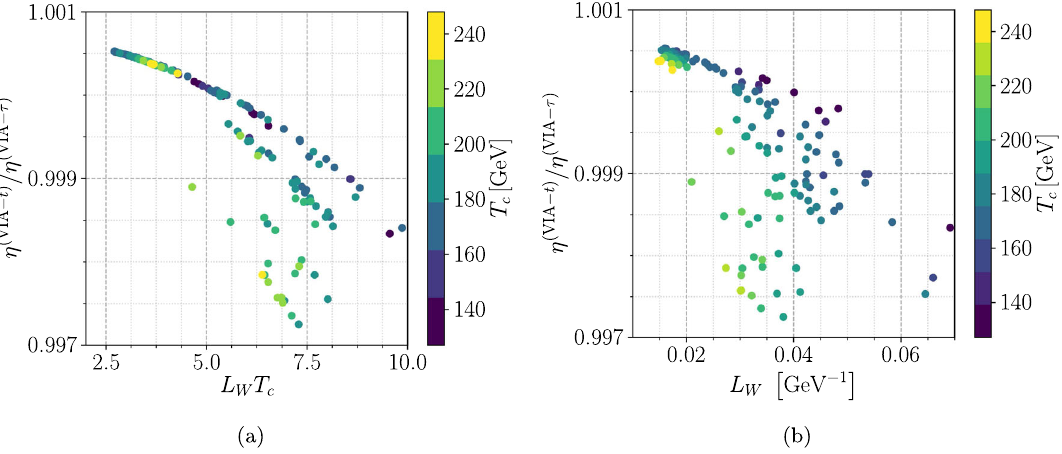
Fig. 9 Ratio between the BAU computed in the VIA − t approach and the VIA − τ approach as a function of L W T c (left) and L W (right) for all allowed parameter points. The colour code indicates the critical temperature T